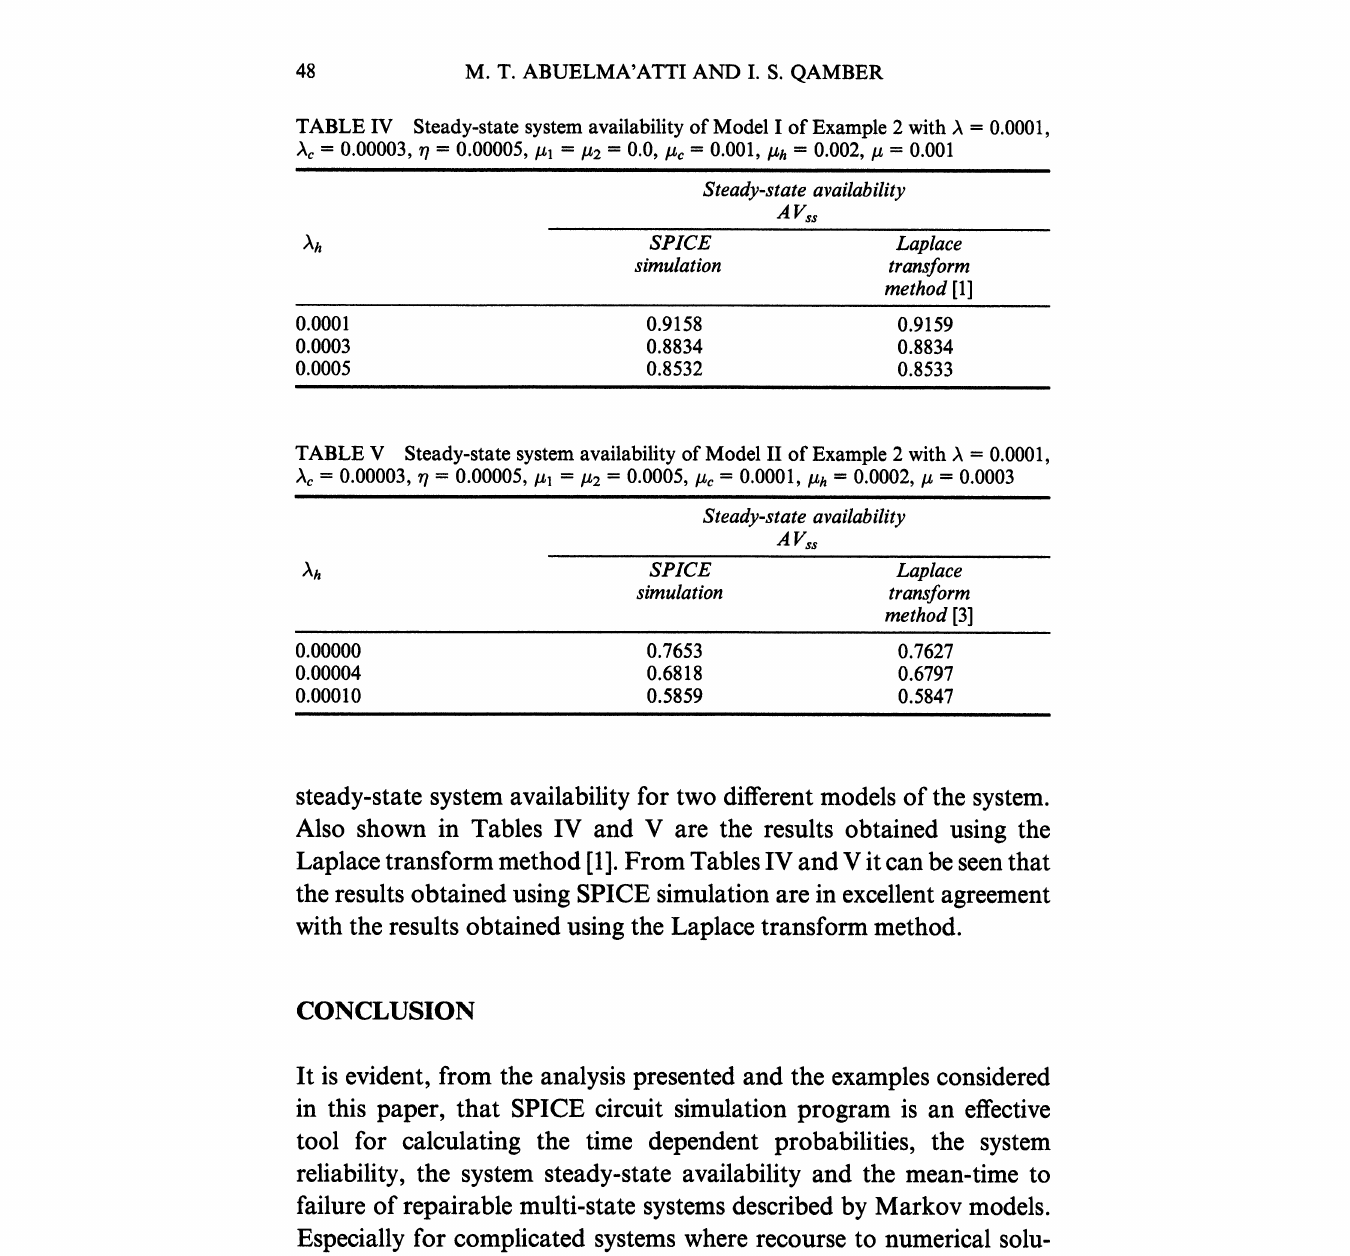
TABLE V Steady-state system availability of Model II of Example 2 with